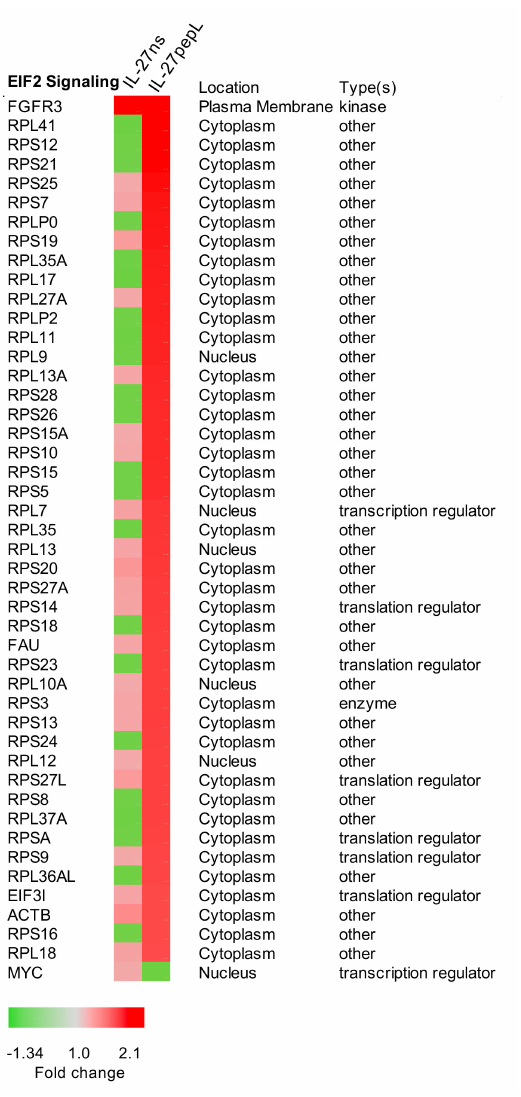
Figure 7. Top canonical pathways that di ff ered between IL-27pepL and controls. This figure shows the most expressive novel signaling pathways for signaling promoted by IL-27pepL, EIF2 α signaling. Color bar: fold